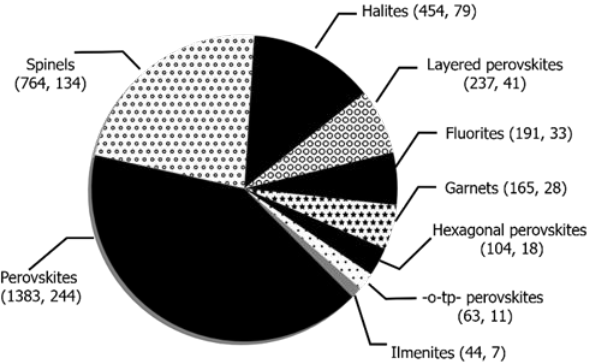
Figure 3. Distribution of the compounds of Figure 1 in the collection to develop 6S10O-WEF. The number of compounds in the traval and test sets is shown in parenthesis. The collection to develop 6S10O-WEF was the most complete of all. The collection used to develop 6S8O-ANNs did not include fluorite and halite compounds. Similarly, the collection to develop 6S4O- and 4S4O-ANNs only contained the garnet, perovskite, and spinel structures. Since the collection used for 4S4O only contained compounds with up to four Wyckoff sites, there were 193 and 57 compounds less with the perovskite and spinel structure. In all the collections, the number of compounds belonging to the “others” structure was equal to the sum of the compounds of all structure types.